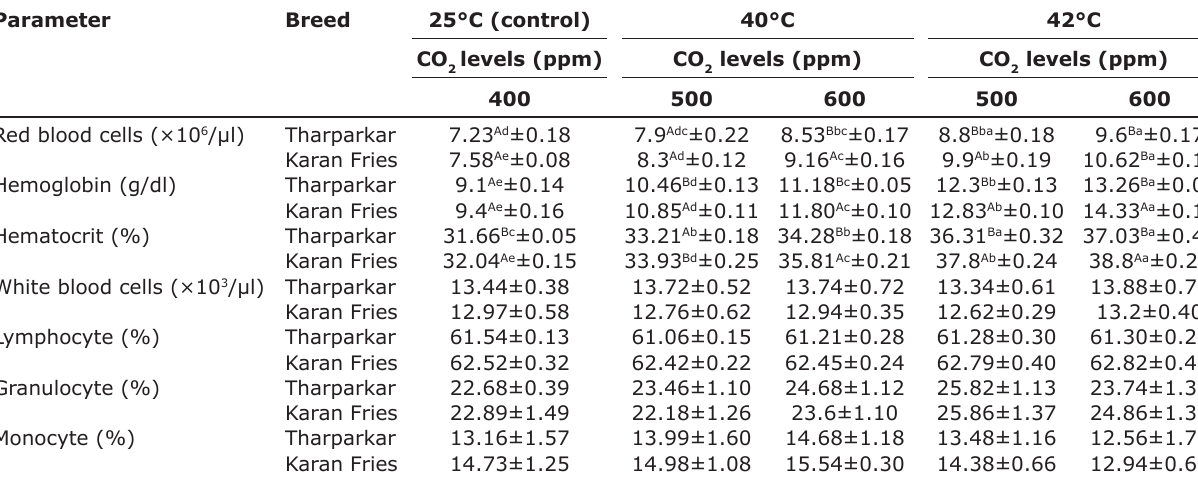
Table-2: Effect of elevated temperature and CO